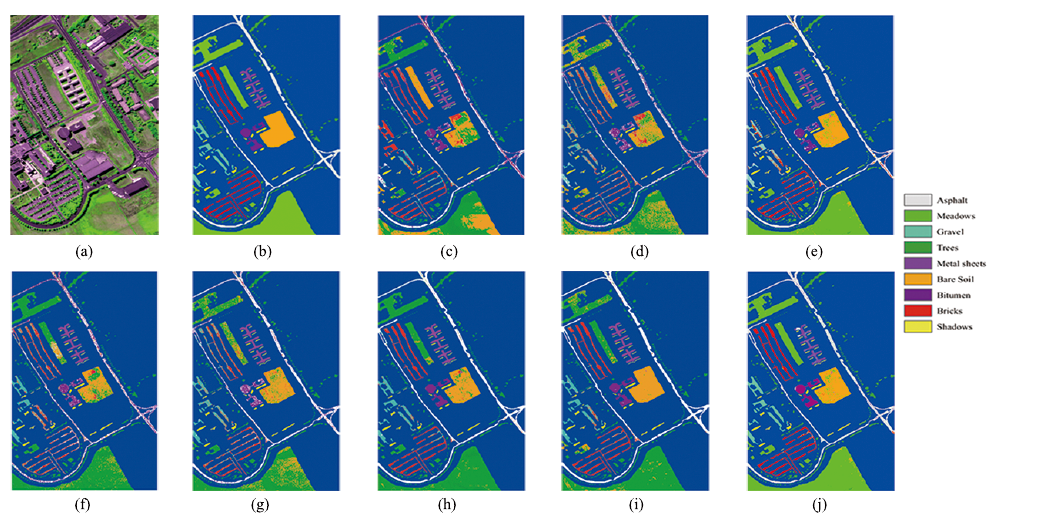
Figure 10. Classification results obtained by different classifiers for the Reflective Optics System Imaging Spectrometer (ROSIS) Pavia University Scene; ( b ) Reference map; ( c ) Spe s classification map; ( d ) EMAP s classification map; ( e ) Deep s classification map; ( f ) Spe o classification map; ( g ) EMAP o classification map; ( h ) NLW-SR classification map; ( i ) SSDCNN classification map; ( j ) Deep o classification